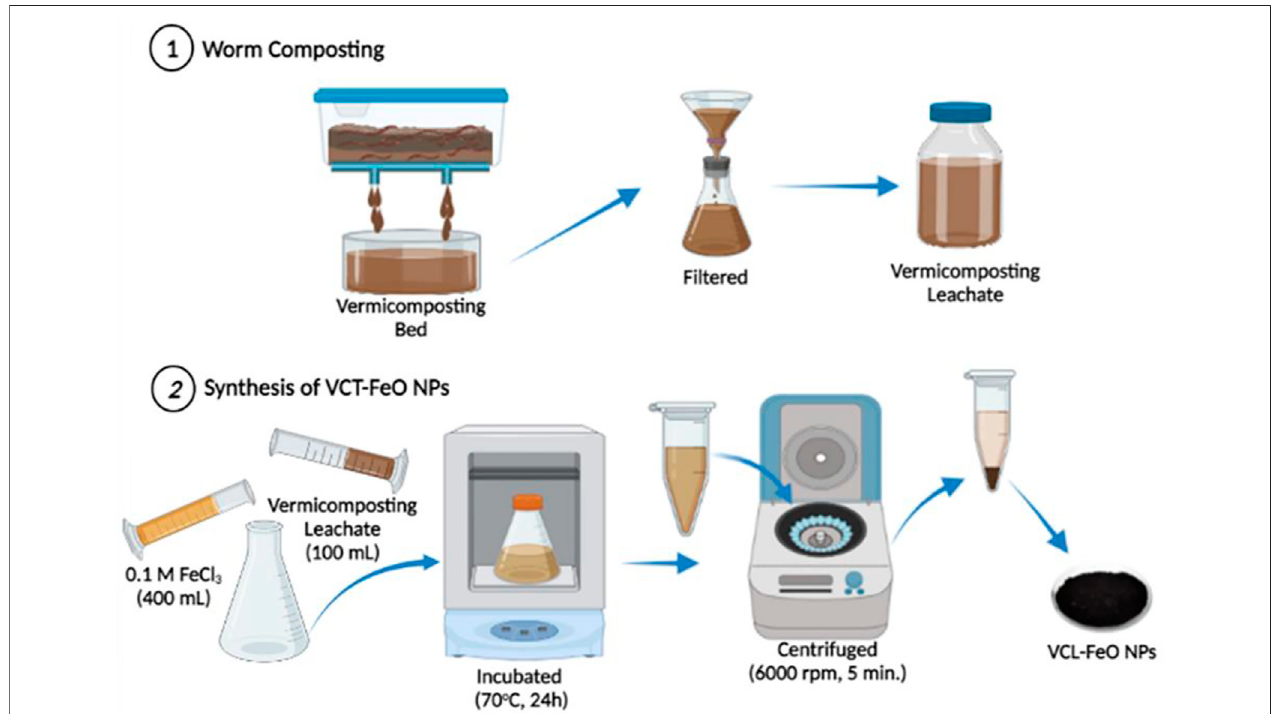
FIGURE 1 | The experimental steps for VCL-FeO-NPs